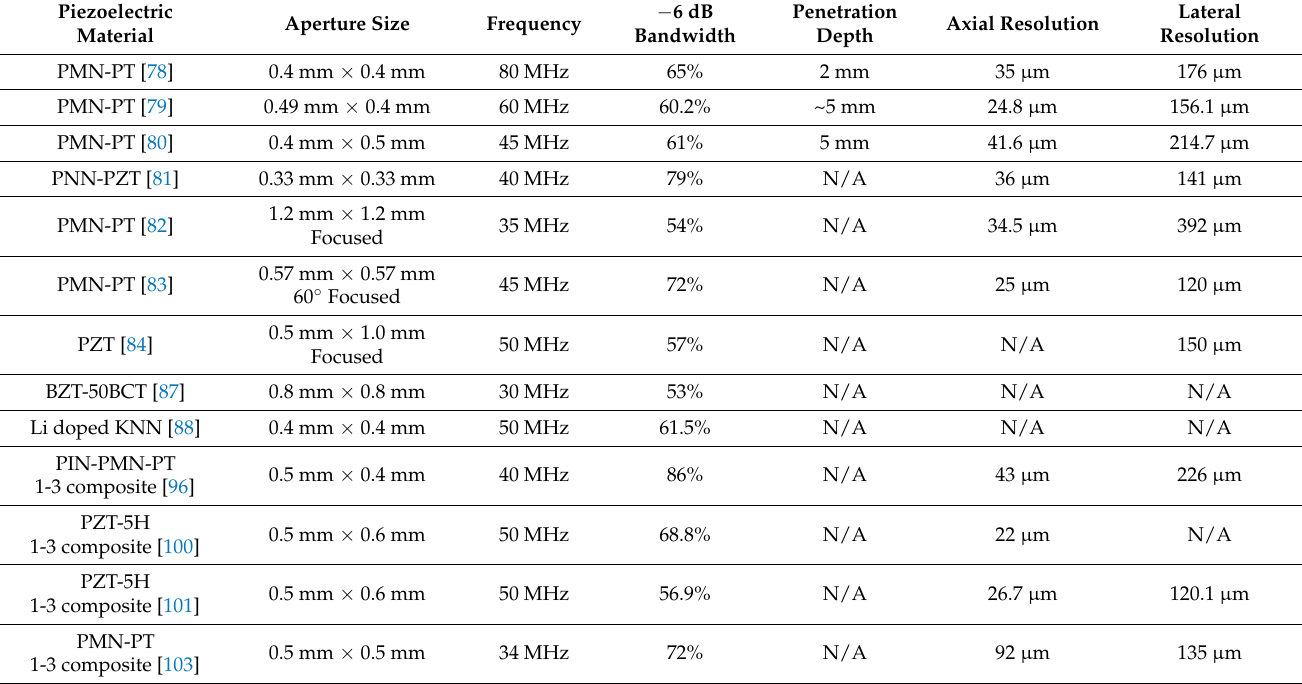
Table 5. IVUS imaging performance comparison of the reported single frequency transducers. Piezoelectric